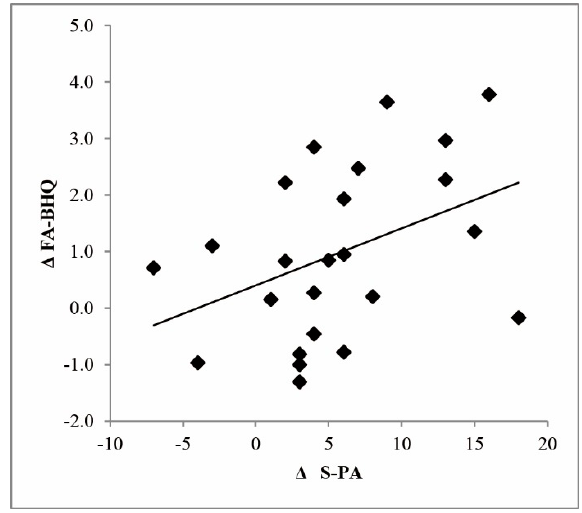
Figure 1. Correlation between the change in brain healthcare quotient based on fractional anisotropy ( Δ FA-BHQ) and the change in the standard verbal paired associate learning test scores ( Δ S-PA).